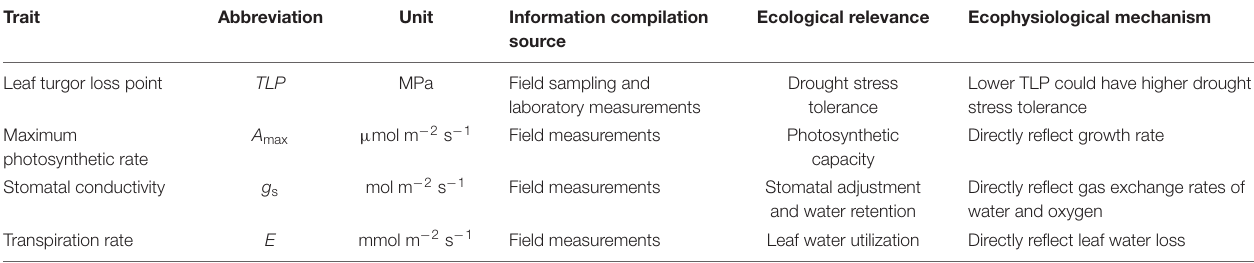
TABLE 2 | Descriptions of the selected plant traits and abbreviations used in this study. Trait